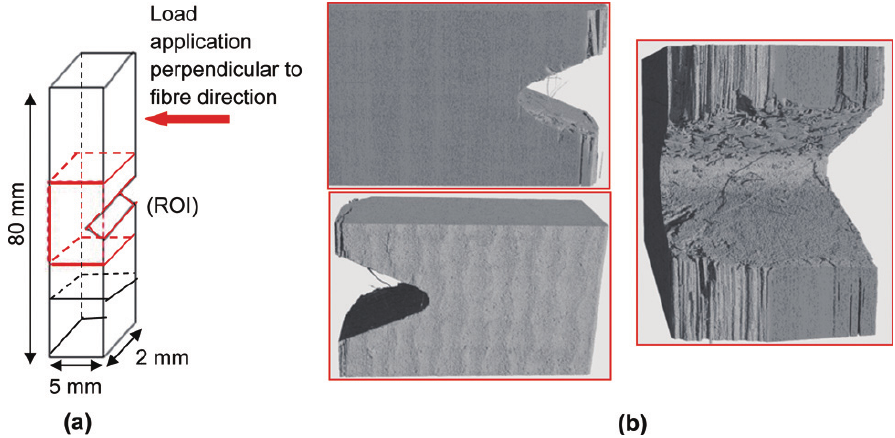
Fig. 5. (a) Specimen schematic highlighting the region of interest (ROI), (b) Side views and front view of the